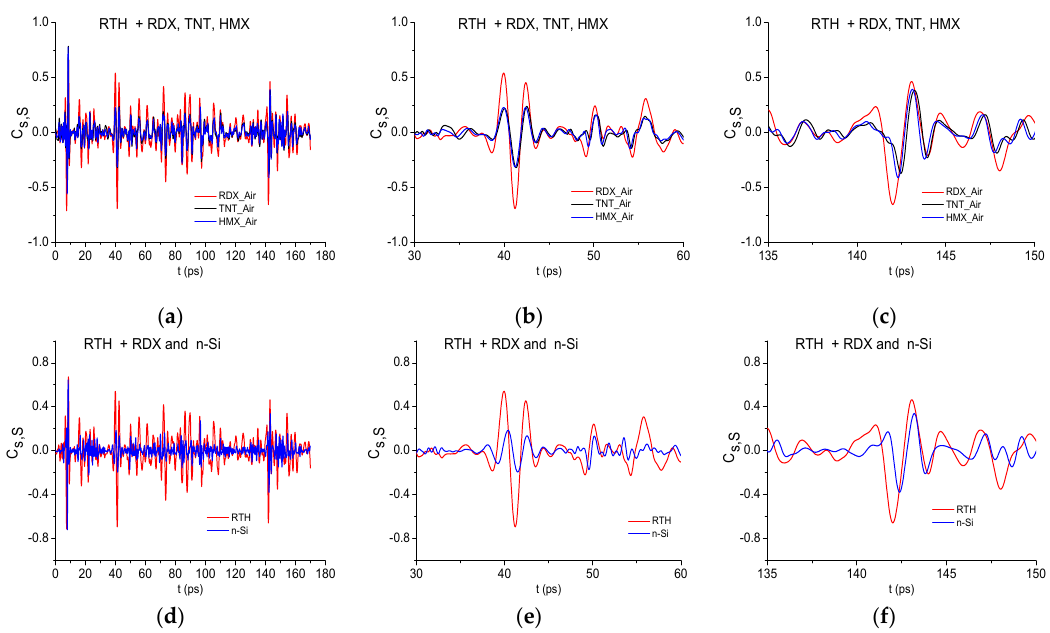
Figure 5. Time-dependent correlation coe ffi cients c s , S between the RTH signal and the standard signals RDX_Air, TNT_Air, HMX_Air, ( a–c ) ; between the RTH and RDX_Air, n-Si signals ( d–f ), depicted in the time intervals t = [0,180] ps ( a,d), [30, 60] ps ( b,e ), [135, 150] ( c,f ).